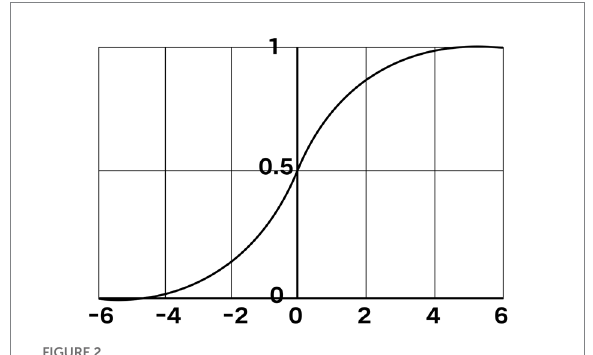
FIGURE 2 Logic distribution function